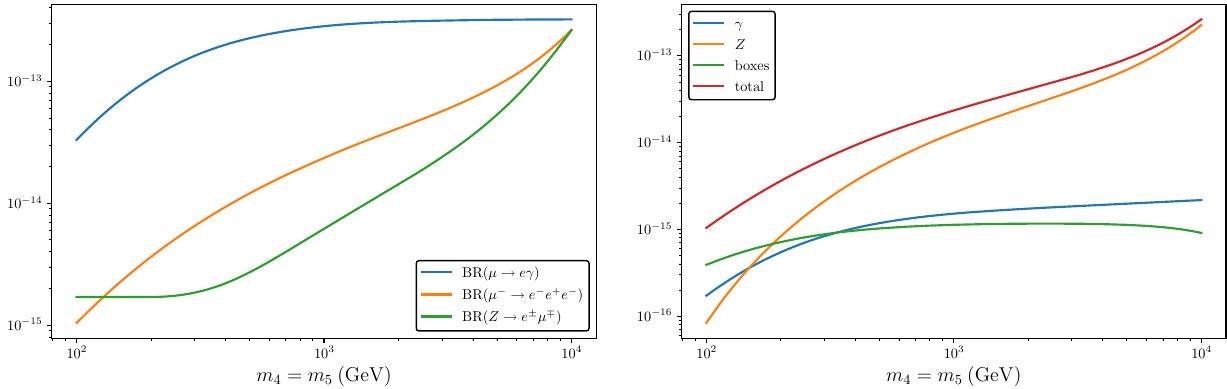
Fig. 4 cLFV observables (left panel) and choice of contributing form factors to the different rates (right panel), as a function of the degenerate heavy sterile mass, m 4 = m 5 (in GeV), for vanishing CPV phases. On the left panel we present BR( μ → e γ ) (blue), BR( μ → 3 e ) (orange) and BR( Z → e μ ) (green); on the right, one finds the contributions of the γ -penguin form factors F β 3 α (orange) and the box form factor F (green) to the total branching ratio of decays of the form (cid:7) β → 3 (cid:7) α (red), choosing for illustrative purposes box α = e and β =